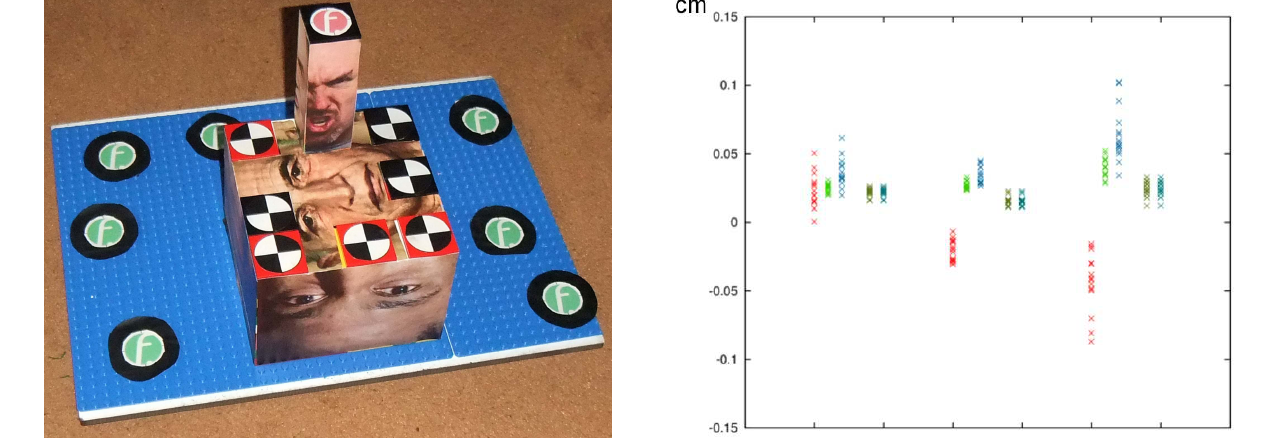
Figure 2: Phantom built from Lego bricks and textured with face image prints. The accuracy evaluation of experiment I is limited to the locations of the “pizza” markers.